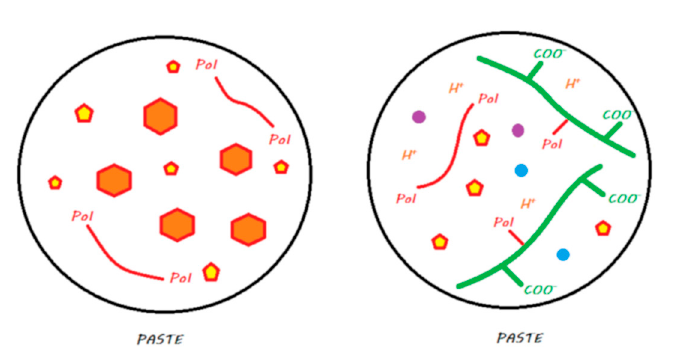
Figure 9. Ketac Nano in its storage medium. The first paste contains silane-treated reactive FAS fillers and unreactive fillers, as well as HEMA monomers. The second paste contains water, an ionized modified polyacrylic acid with photopolymerizable groups, camphorquinone as a photoinitiator, a blend of monomers including HEMA, and silane-treated unreactive fillers.